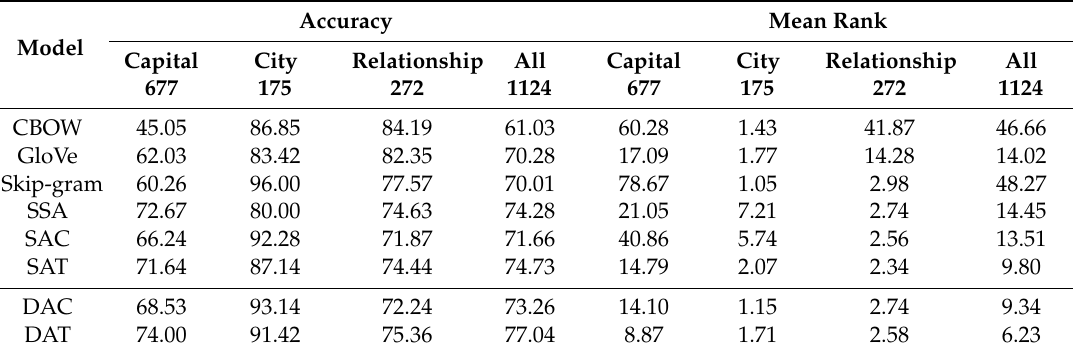
Table 4. Evaluation results of word analogy